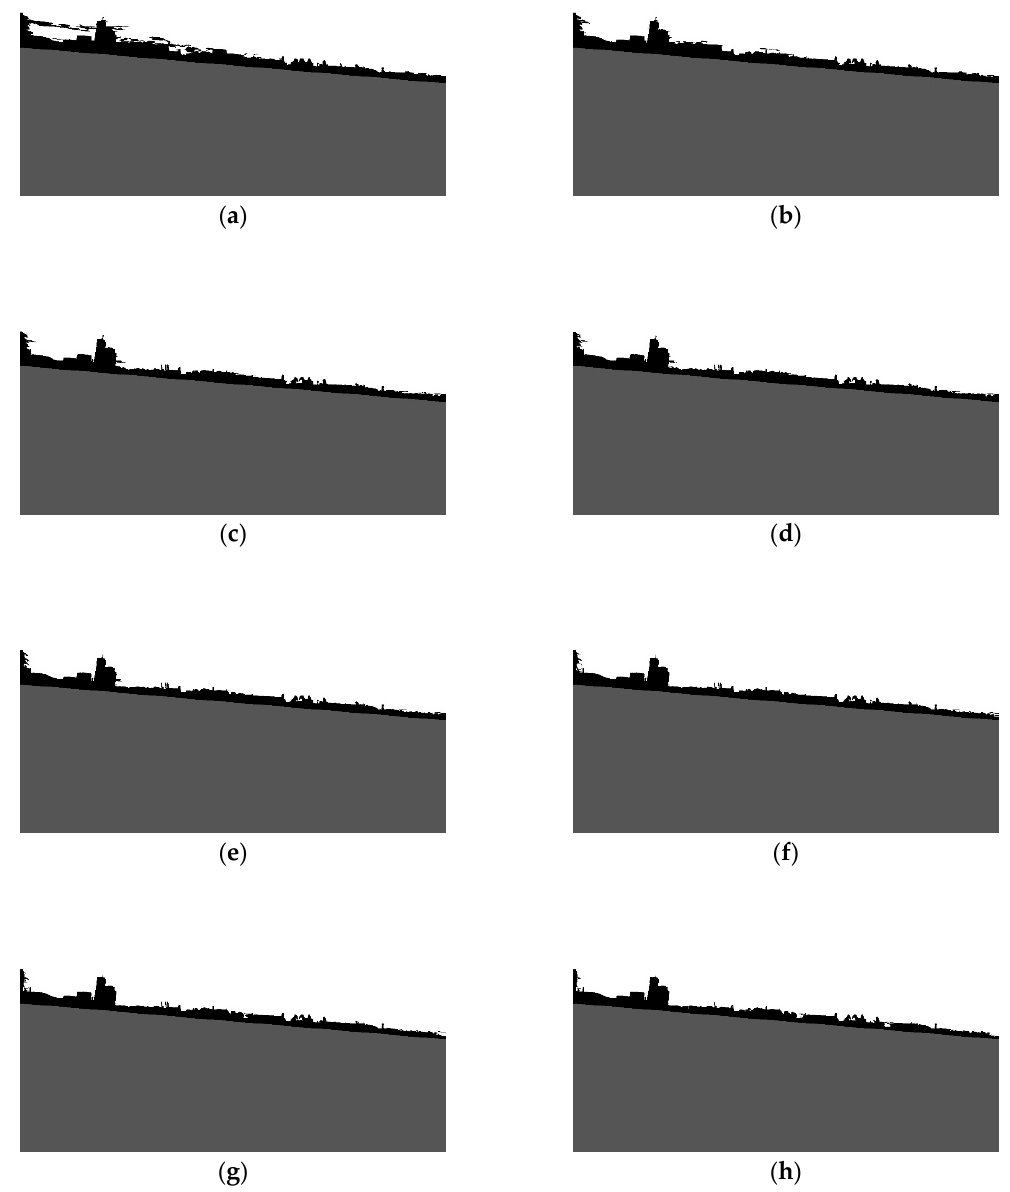
Figure 6. Results of progressive segmentation: ( a ) Level 0; ( b ) Level 1; ( c ) Level 2; ( d ) Level 3; ( e ) Level 4; ( f ) Level 5; ( g ) Level 6; ( h ) Level 7.